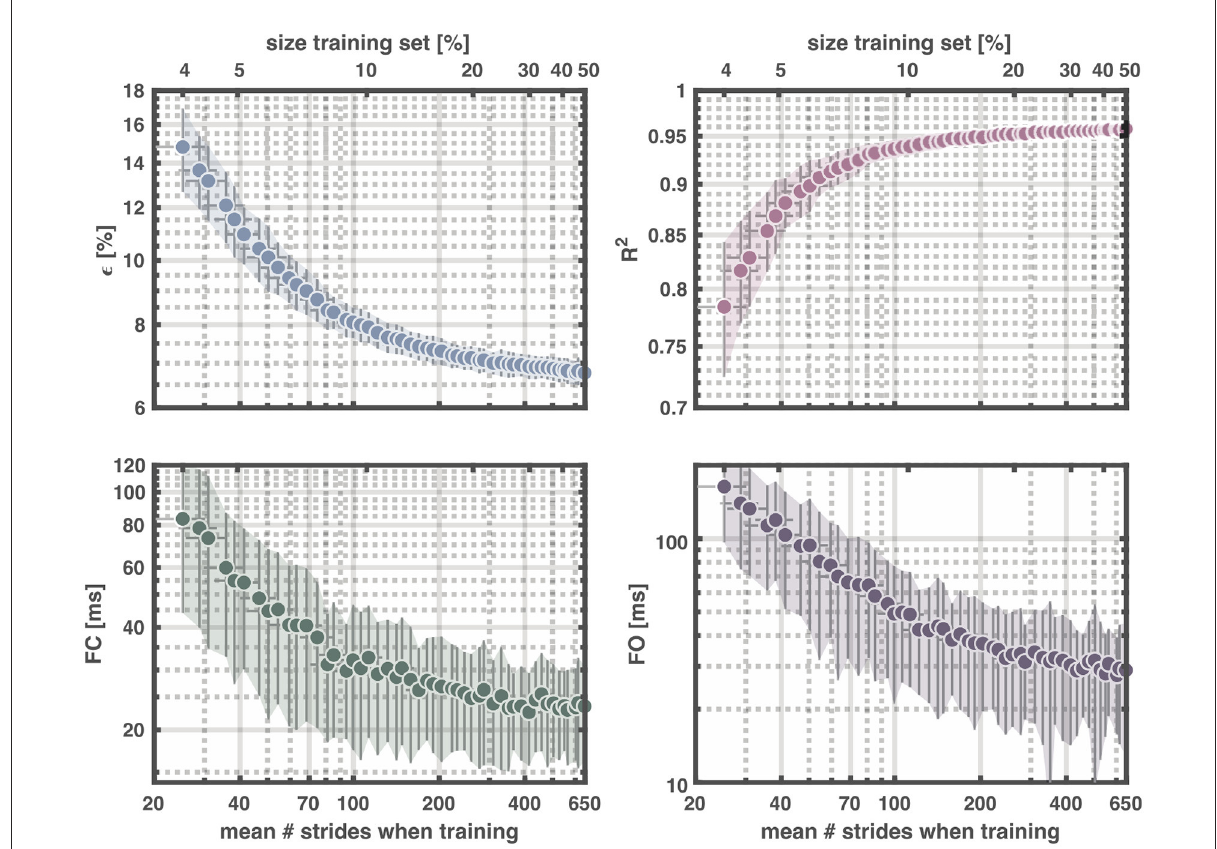
FIGURE5 Output of reservoir computer with training data ranging from 4-50% of the total dataset and validating and testing with 25%, respectively. Upper left panel : Normalized root-mean squared error ( ǫ ), upper right panel : Coefficient of determination (R 2 ), lower left panel : Mean absolute error of foot contact, and lower right panel : Mean absolute error of foot off. Upper x-axes show the percentage of the total dataset used for training and the lower x-axes the corresponding mean number of strides. Each dot represents the mean value for 100 repetitions. The vertical error-bars and colored areas represent the standard deviation of the corresponding measure. The horizontal error-bars represent the standard deviation in the number of strides across the 100 repetitions. FC, foot contact; FO, foot off.